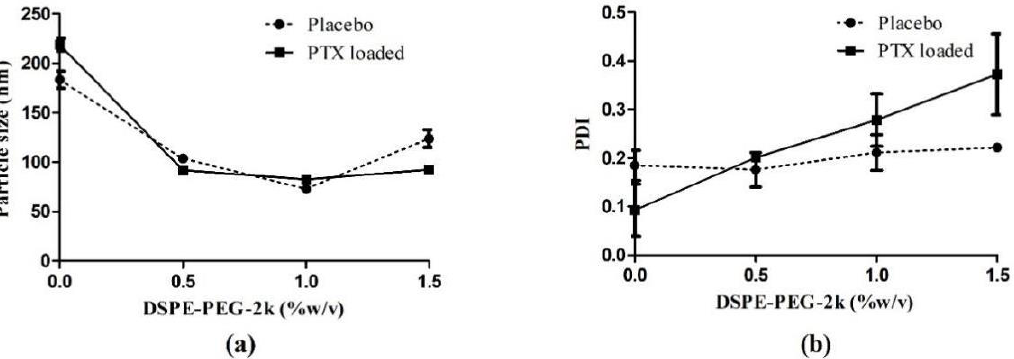
Figure 5. Effect of the concentration of DSPE-PEG-2k on the particle size ( a ) and PDI ( b ) of the NLC